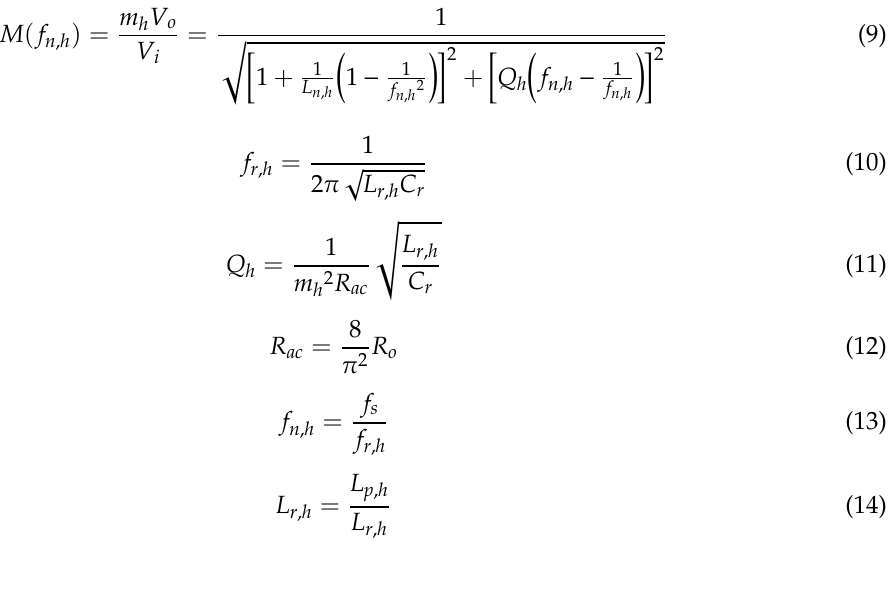
Figure 5. Equivalent circuit models of the resonant tank during the positive cycle (lower left) and negative cycle (lower right).